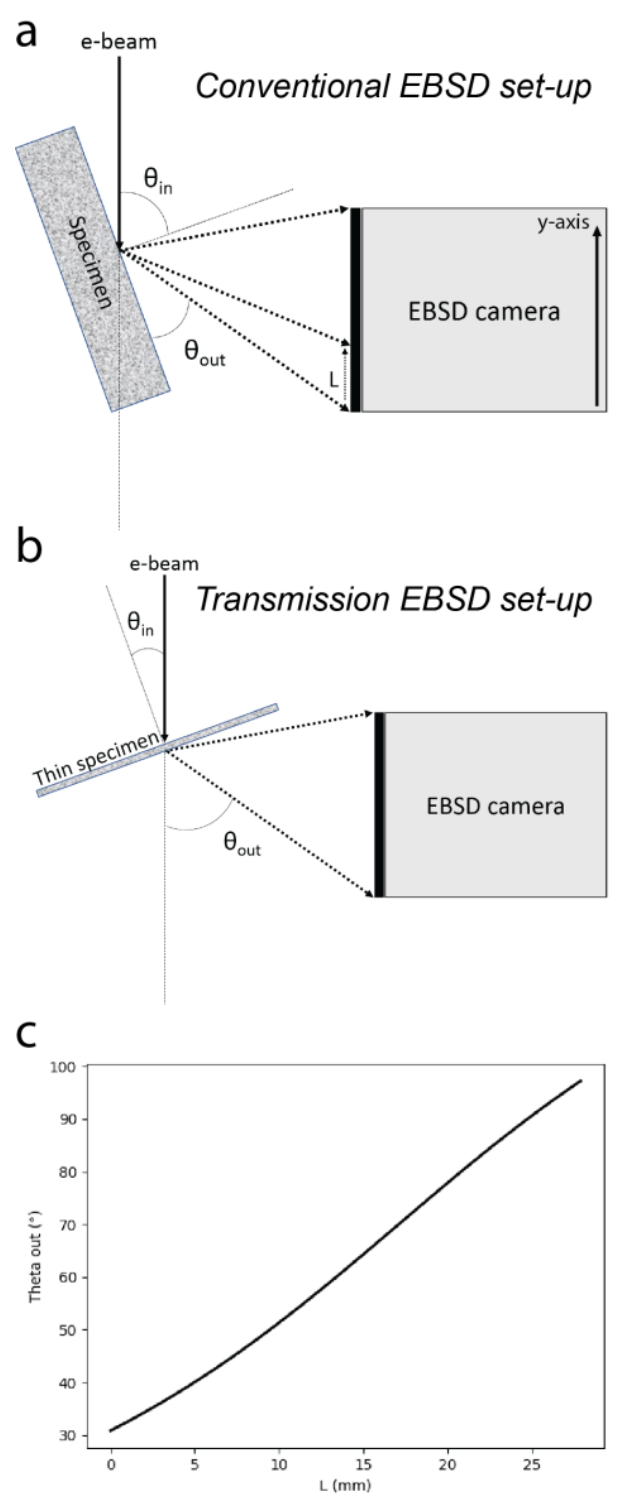
Figure 1. Schematics describing ( a ) the conventional electron backscattered diffraction (EBSD) set-up and ( b ) the transmission EBSD (t-EBSD) set-up; ( c ) Calibration relating the BSE emission angle θ out and the distance L from the bottom of the EBSD camera screen. SINGLE COLUMN.